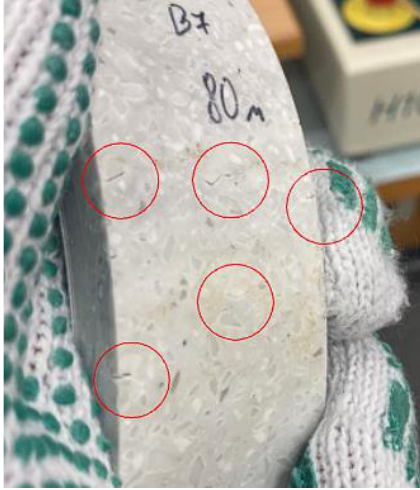
Figure 9. Patterned artificial cast stone after bending test at 170 °C (cracks are marked in red).